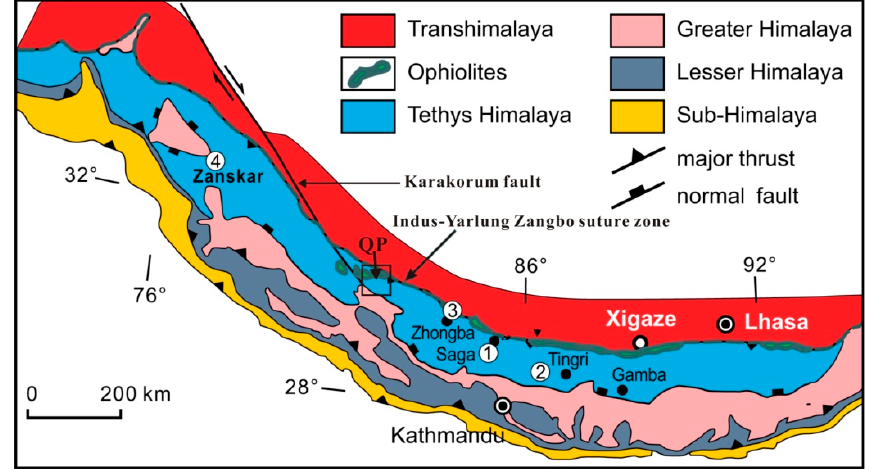
Figure 1. Simplified geologic map of the Himalayas to show the locations of the study area, the QP geothermal field, the Karakorum fault, and the Indus ‐ Yarlung Zangbo suture zone (modified from Hu et al. [15]).